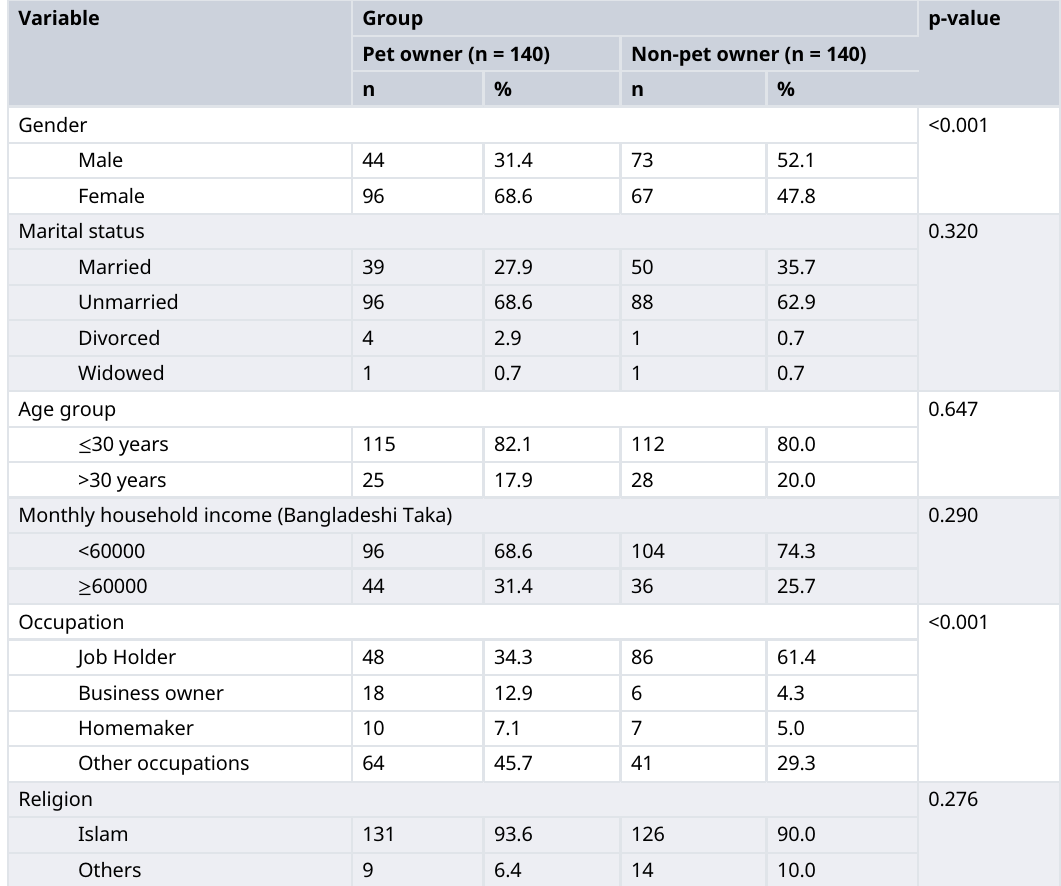
Table 2. Sociodemographic characteristics of the participants.